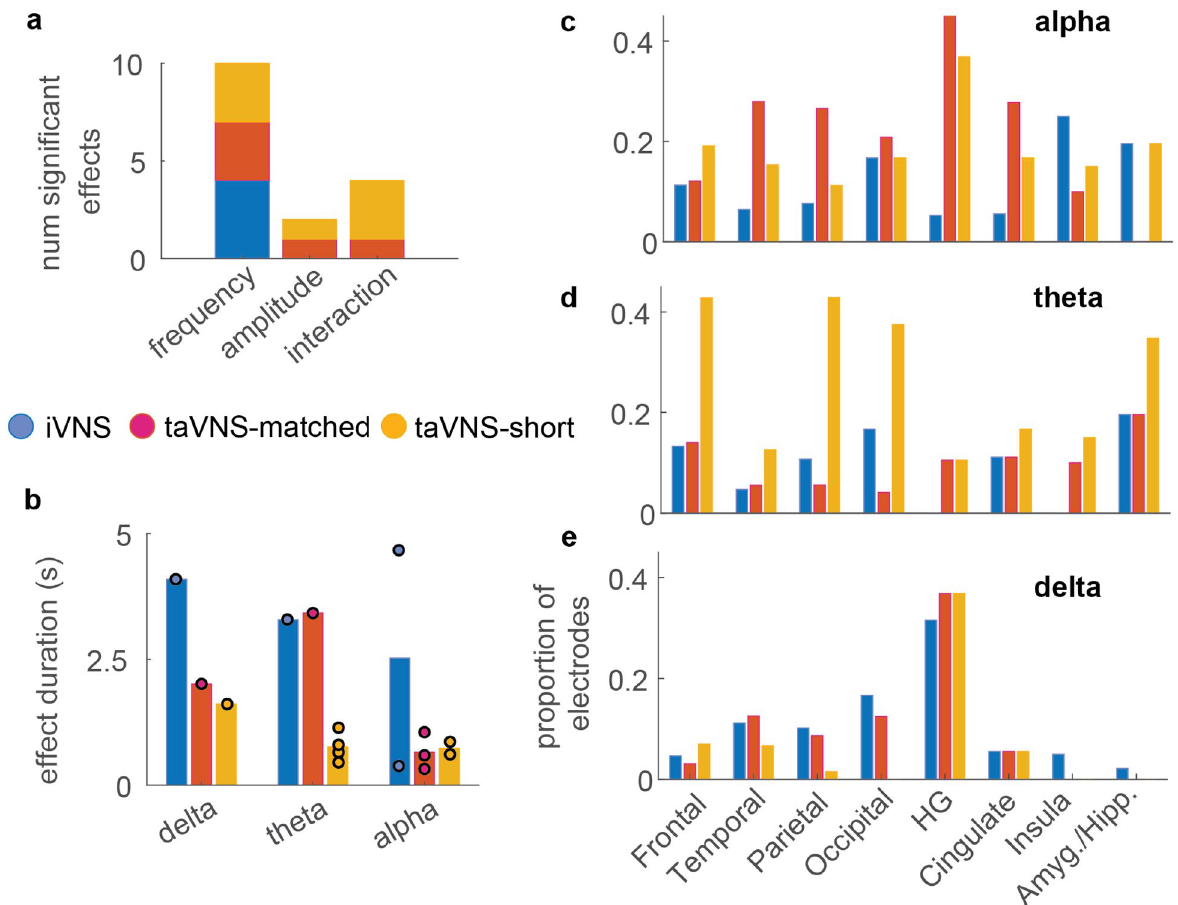
Figure 4. Spatial and temporal similarities between invasive and non-invasive VNS ( a ) Number of significant spatiotemporal clusters for each effect type (x-axis) and modality (color), aggregated across all spectral bands. ( b ) Total duration of significant non-parametric cluster permutation windows in each spectral band (x-axis) and modality (color). Single data points indicated by filled circles, average duration indicated by vertical bar. ( c–e ) Proportion of significant electrodes in seven regions of interest (ROIs; Amyg. = amygdala, Hipp. = hippocampus, HG = Heschl’s Gyrus) across all seven participants in the study, corresponding to spectral bands in ( c–e ) Colored bars represent, for each stimulation modality (iVNS, taVNS-matched, taVNS-short), the proportion of all electrodes within an ROI (x-axis) that were assigned to a cluster in which a significant difference between stimulation conditions was found. While proportions differ between modalities (potentially due to differences in sample size), all three are associated with changes in activity in multiple cortical and limbic areas.